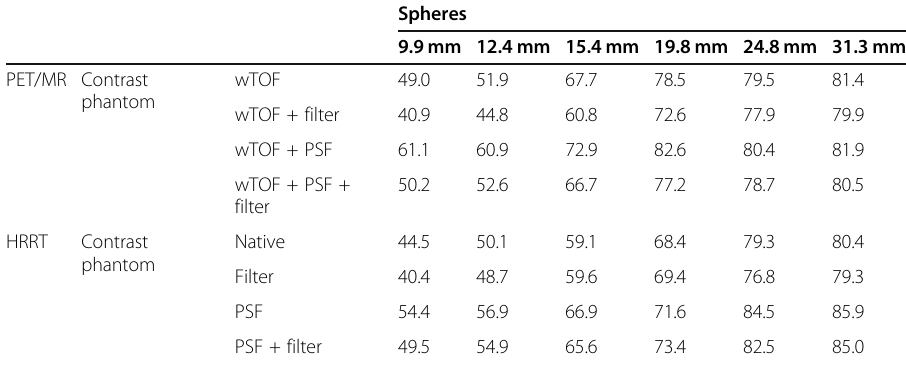
Table 5 RCs for the contrast phantom scanned on the PET/MR and HRRT